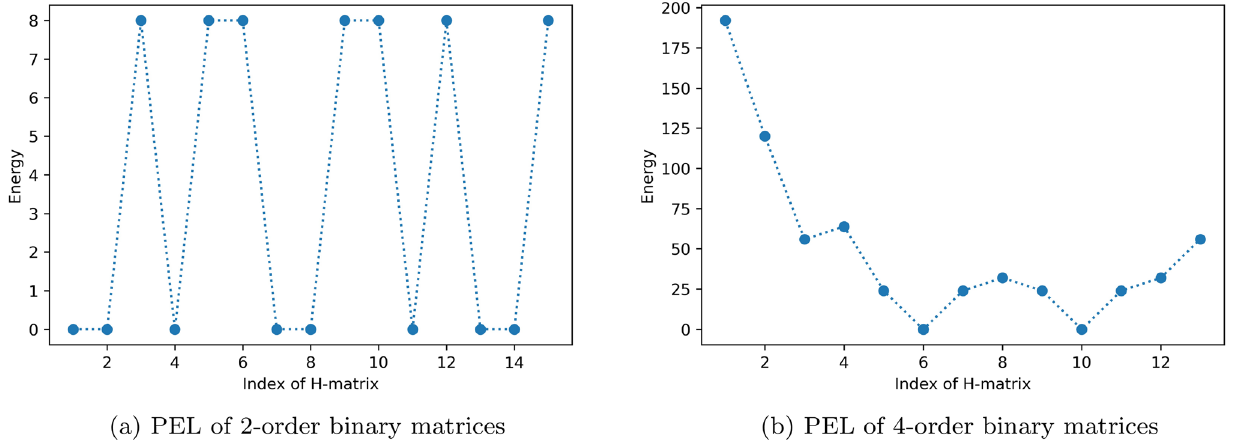
Figure 1. Potential Energy Landscape (PEL) of 2-order and 4-order binary matrices. The energy of the T B binary matrix B is calculated from sum of the squared off-diagonal of the D matrix, where D = B , similar to Eq. (8) in our previous paper 21 . In ( a ), the 2-order binary matrices are generated and their energies are plotted against their indices. The indices are converted to the matrices after a binary to spin variable transform. As an example, for the second matrix with index 1, then the process is as follows: 1 1 (cid:30) 1 → 0001 → [ 1, 1, 1, − 1 ] → (cid:31) . Zero energies matrices, such as ones with indices 1, 2, 4, . . . indicates 1 − 1 orthogonal/Hadamard matrices. In ( b ) a few number of 4-order binary matrices neighboring (in term of Hamming distance) to an orthogonal matrix are plotted. Matrices with index 6 and 10 are Hadamard and therefore they are in global minima, while other matrices are not. An example of local minimum is given in the matrix with index 3. We can observe degeneration of energies in both of these 2 and 4 binary